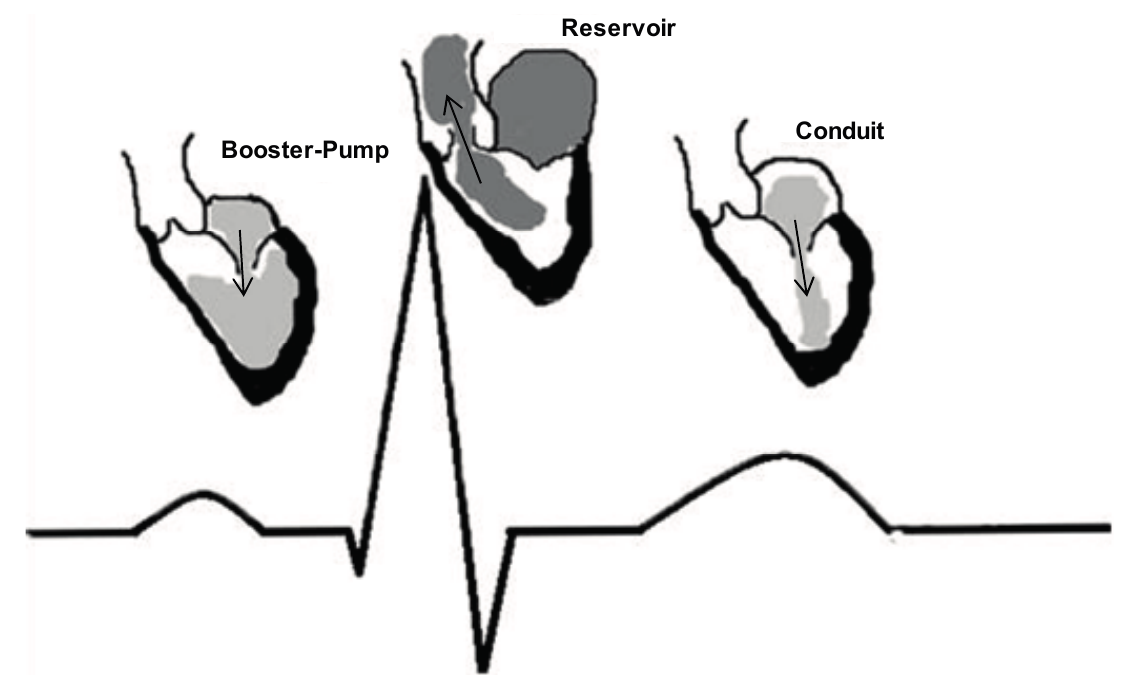
Figure 1. The three integrated phases of left atrium (LA) function in relation to the electrocardiogram (ECG).